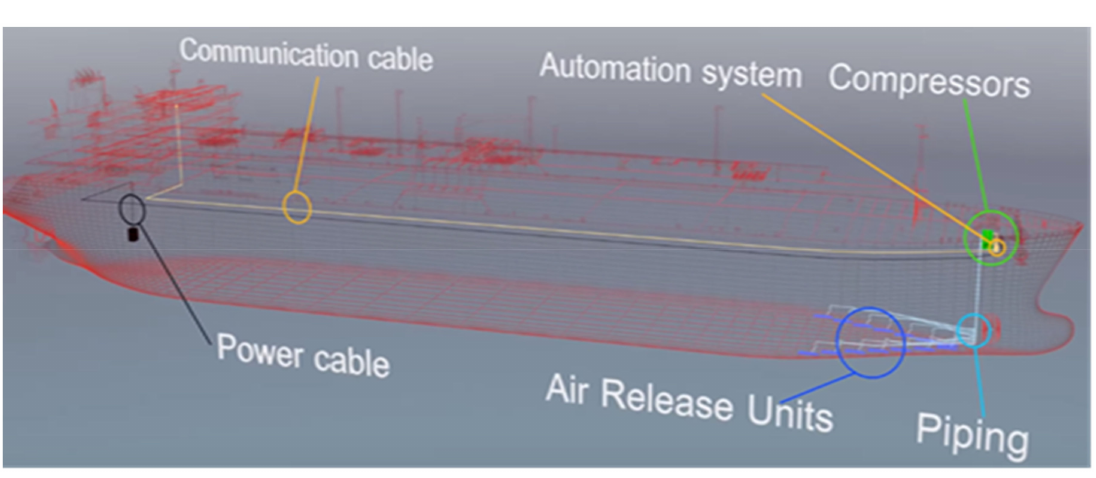
Figure 10. Representation of an integrated system in a ship.